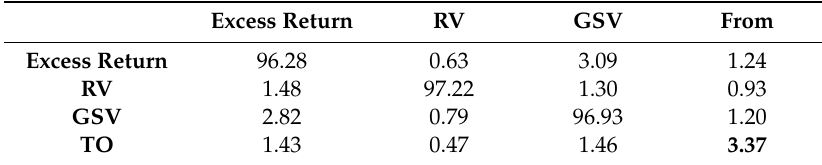
Table 10. Total spillover, Slovakia.